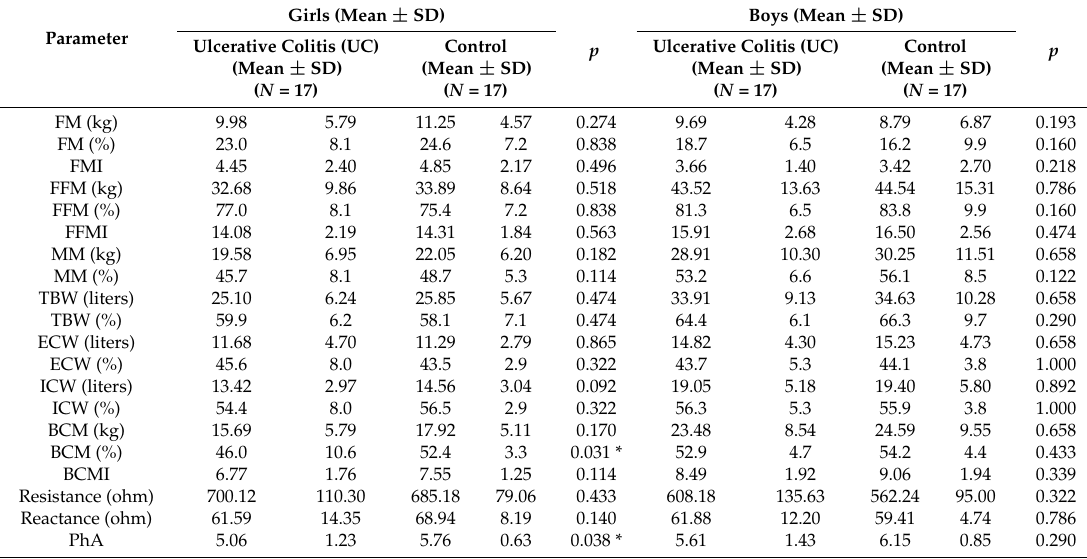
Table 3. BIA results in UC participants according to gender.